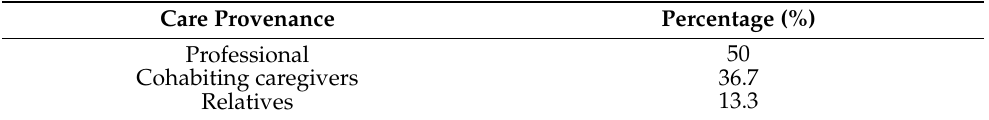
Table 3. Source of care for family members with dementia; percentage distribution. Source: own elaboration based on data drawn from the